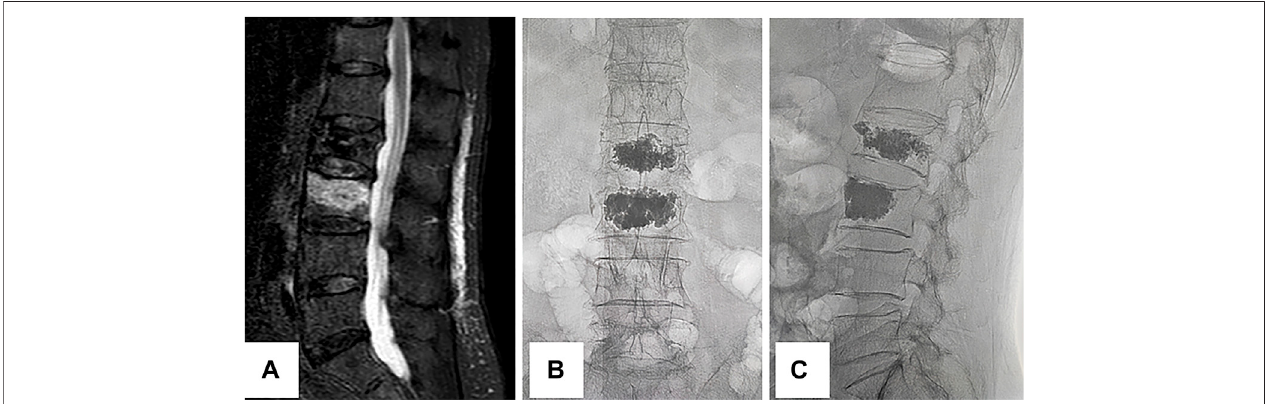
FIGURE 1 | New fracture of the adjacent vertebral body. This is an 89-year-old female with lower back pain and limited mobility. She developed these symptoms after accidentally falling 1 day ago. The pain can be relieved with bed rest and is aggravated when her position changes. The preoperative magnetic resonance imaging (A) suggests a fresh fracture of the L3 vertebral body. The patient underwent L2 vertebroplasty 3 years ago for an osteoporotic vertebral compression fracture. She underwent L3 vertebroplasty on this occasion because of a compression fracture of the adjacent vertebral body. Her pain is relieved after surgery, and postoperative fl uoroscopy with anteroposterior (B) and lateral (C) positions indicate satisfactory bone cement fi lling.